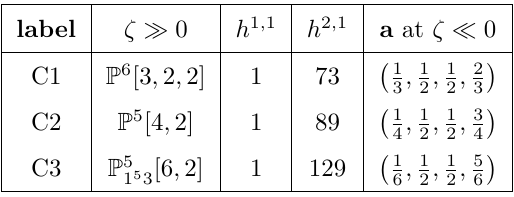
Table 2 . C -type pseudo-hybrids from U(1)